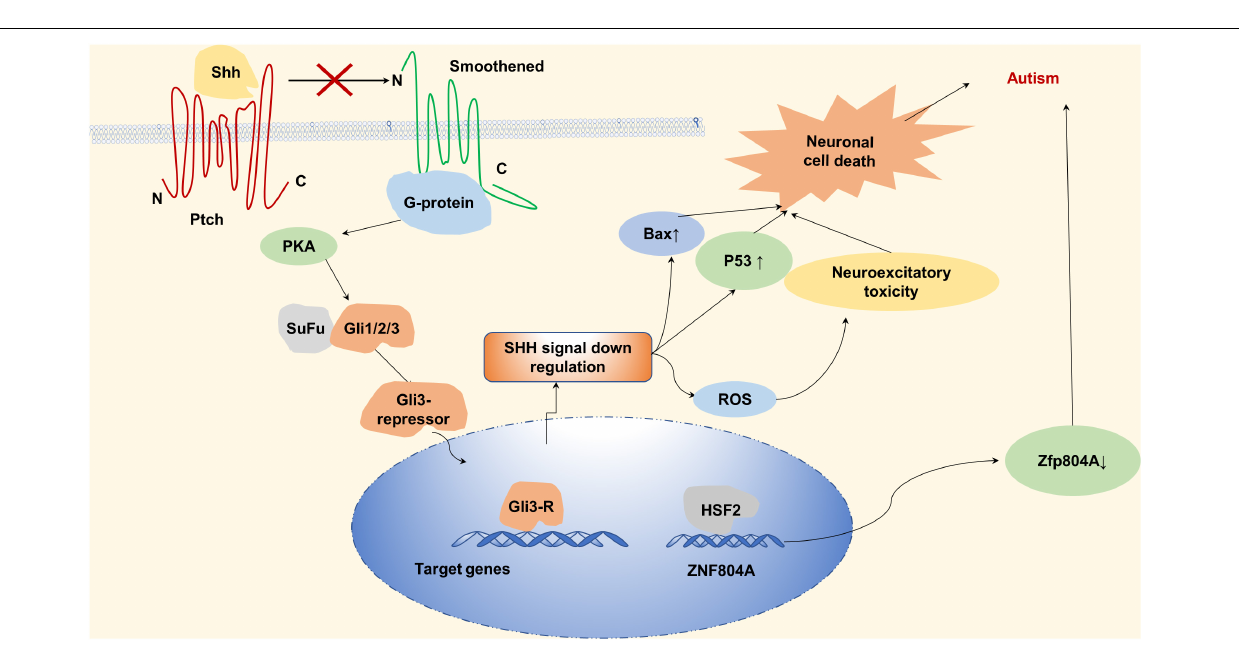
Frontiers in Neuroscience |